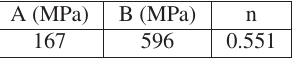
Table 2. Johnson Cook parameters for the aluminum